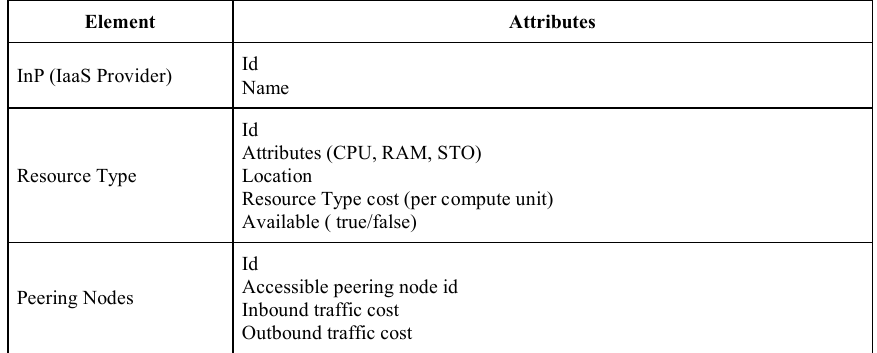
Table 1. Data structure of virtual cloud resource model